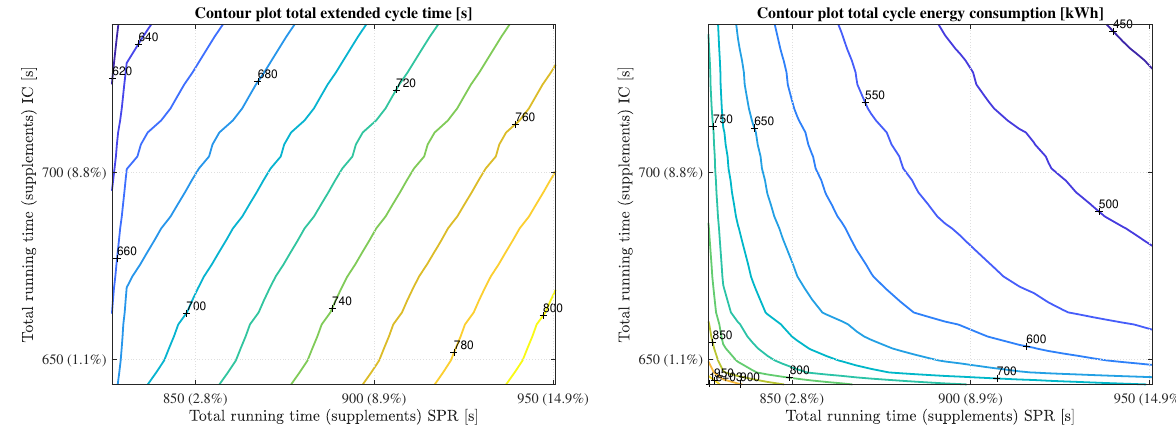
Figure 8: The left plot shows the contour plot for the case Ah-Nm for the extended cycle time over the total running time (supplements) for the SPR and IC. The right plot indicates the contour plot for the total total cycle energy consumption over the the total running time (supplements) for the SPR and IC for the case Ah-Nm.